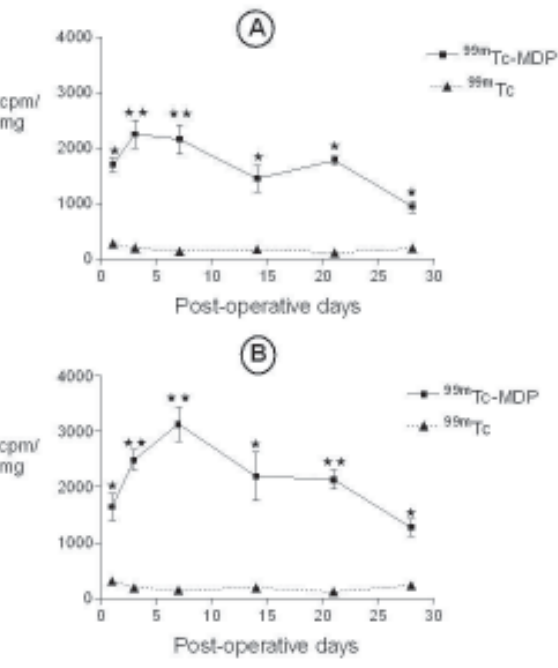
in left tibiae 4